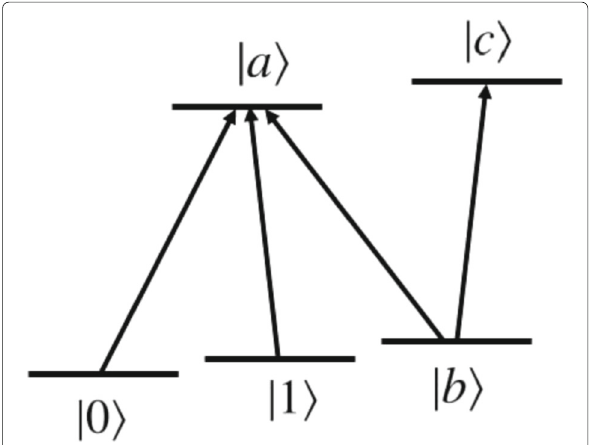
Fig. 2 The level configuration of the five-level connecting system. Two lower levels of this system are used as logical states | 0 (cid:4) and | 1 (cid:4) . The other three levels are used as auxiliary states | a (cid:4) , | b (cid:4) , and | c